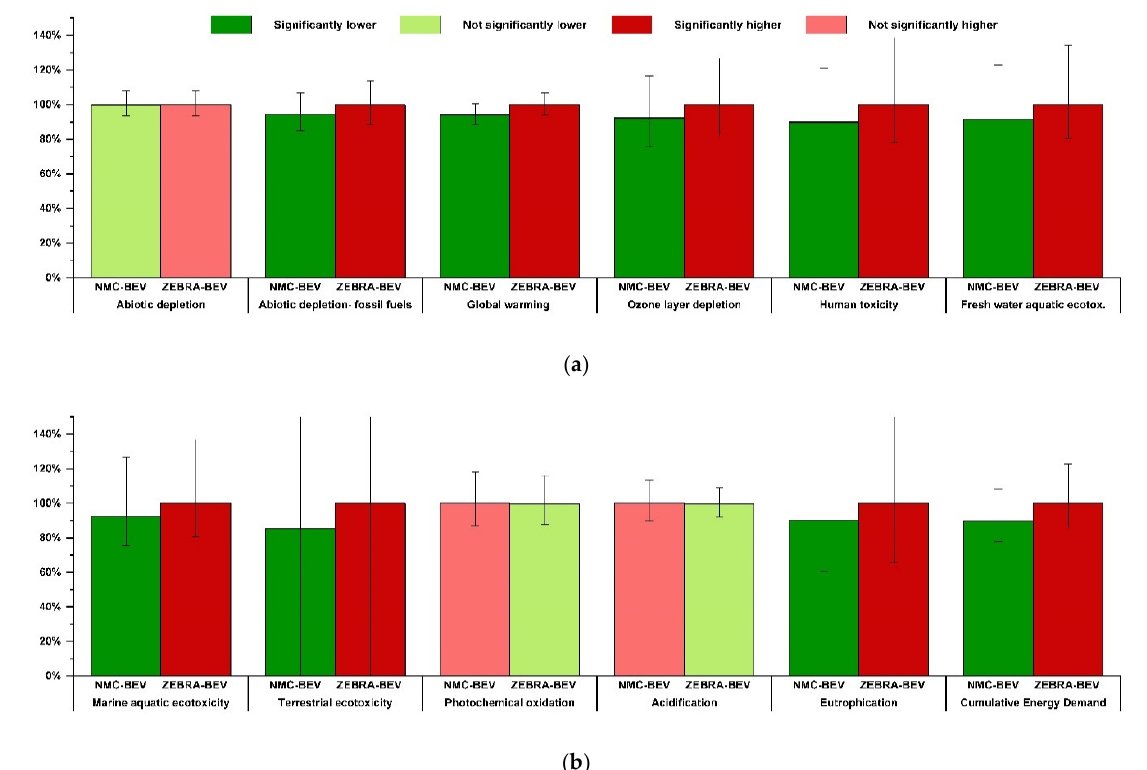
Figure A3. ( a , b ) Graphical representation of the comparison of the uncertainty range of the BEV vehicles, varying the production location of the NMC battery. In this Monte Carlo analysis, the NMC-BEV is powered by 3 battery packs. Some impact categories present higher values than 140% and lower ones than 0%.